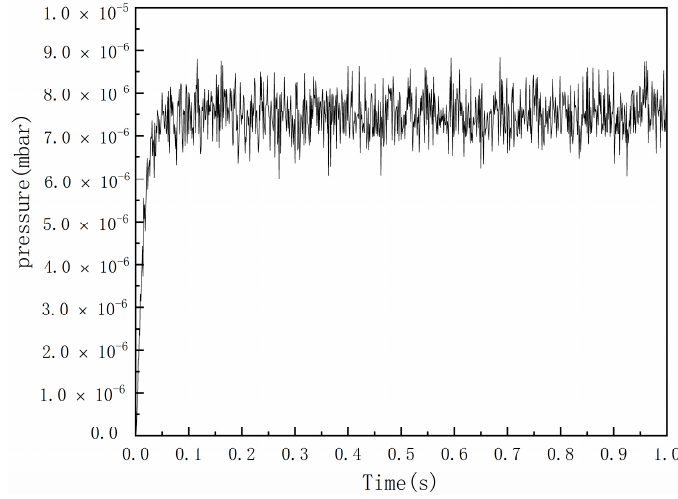
Figure 6. The change in the average pressure of the neutralized area of the vacuum chamber over time during the 1 s pulse.